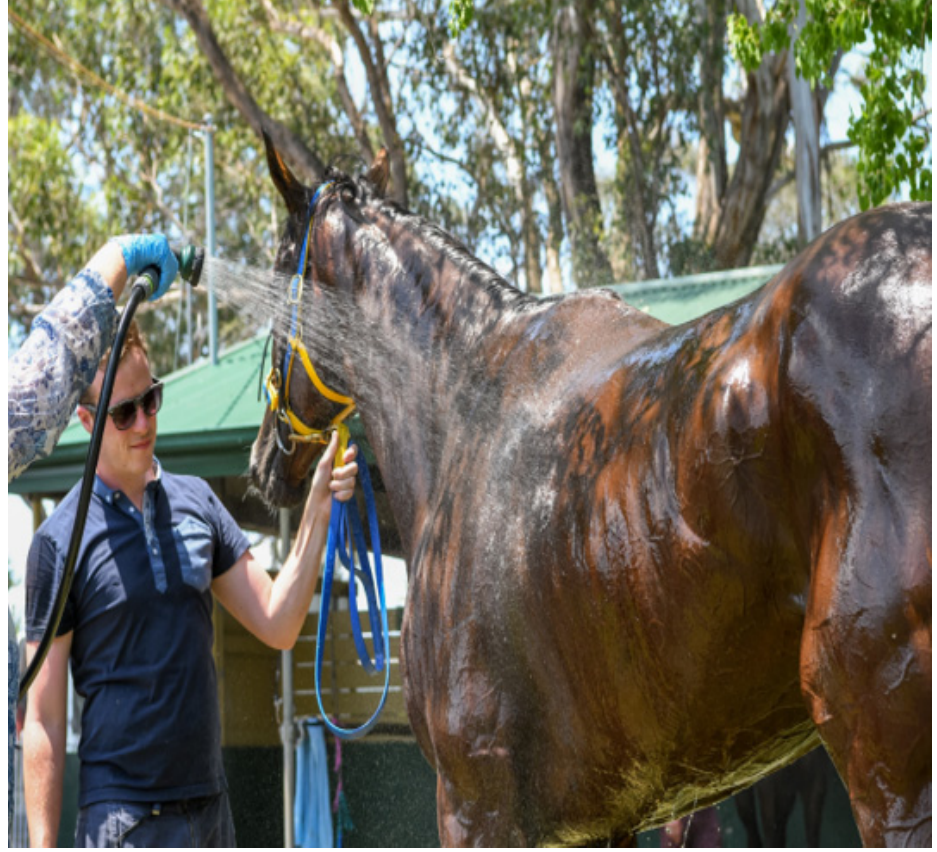
Figure 18. A horse being spray-hosed with ice-cold water. The nozzle type is important because uniform droplet size will guarantee a more even coverage of water.